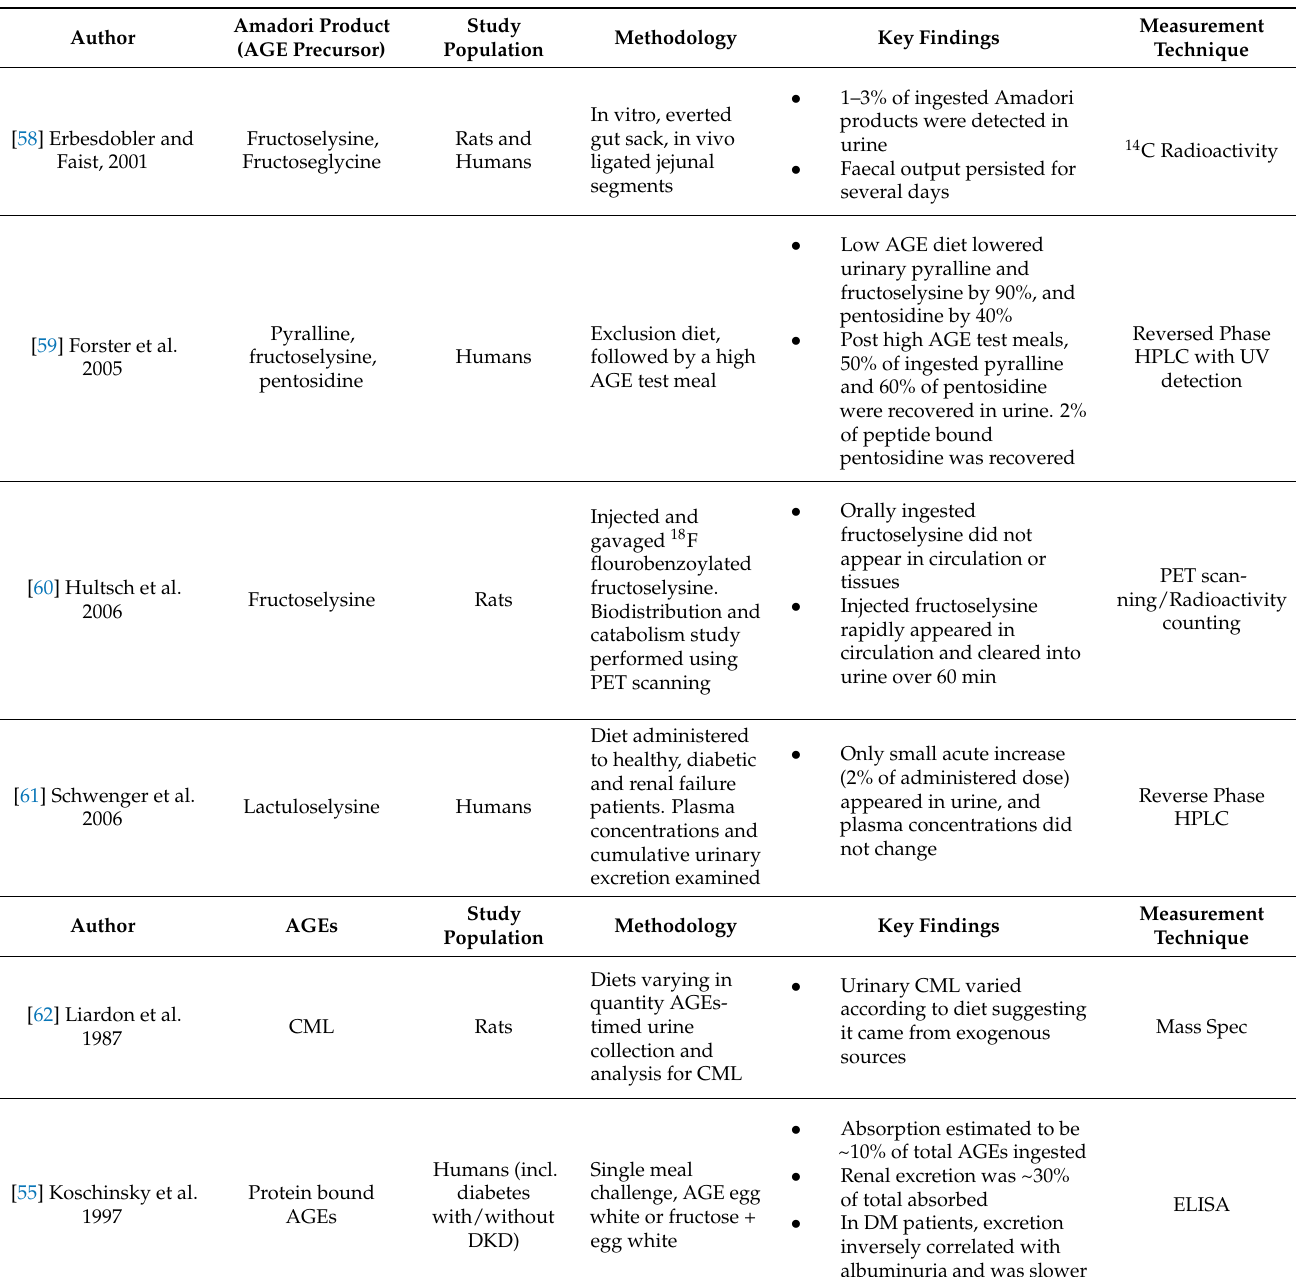
Table 1. Uptake, elimination and biodistribution studies of AGEs and their precursor Amadori